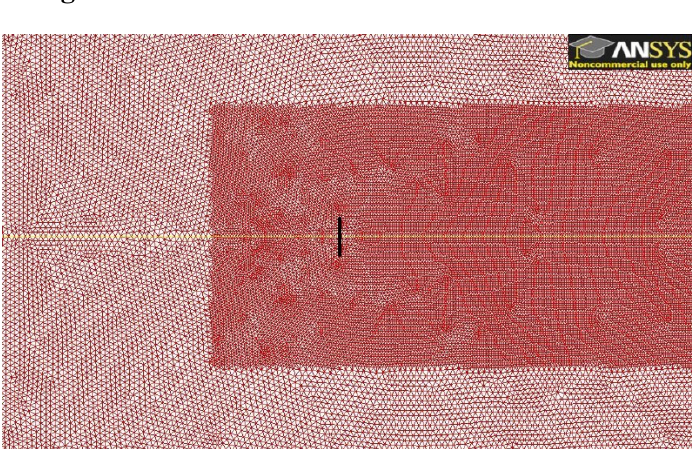
Figure 2. Unstructured mesh around turbine